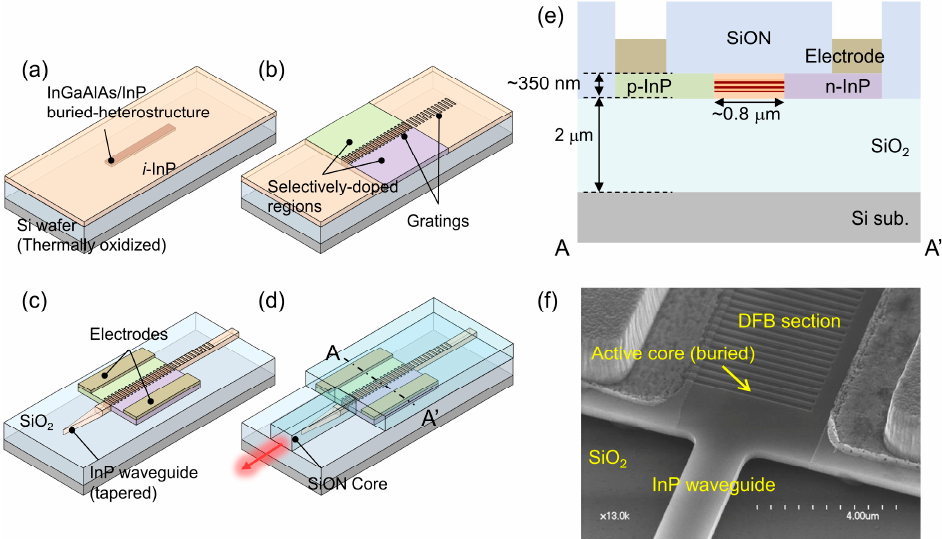
Figure 9. ( a – d ) Fabrication procedure of membrane distributed reflector (DR) laser using In ‐ GaAlAs MQWs grown on InP ‐ on ‐ insulator substrate; ( e ) schematic of cross ‐ section of DR laser; ( f ) InP-on-insulator substrate; ( e ) schematic of cross-section of DR laser; ( f ) bird’s eye view of laser before integration of the bird’s eye view of laser before integration of the spot ‐ size converter (SSC). spot-size converter